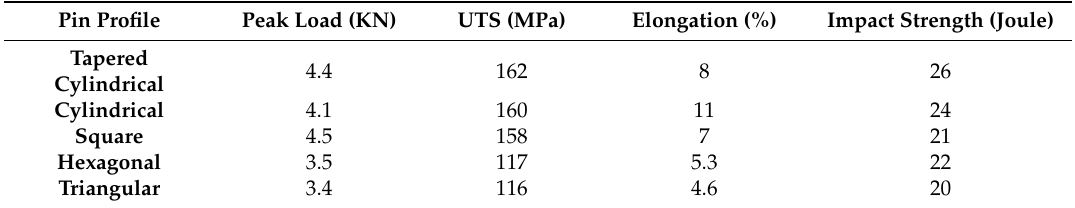
Table 5. Butt joint configuration tensile and impact test results for different pin profiles.